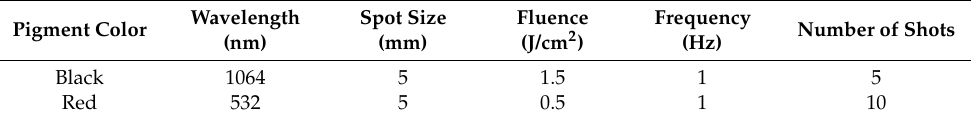
Table 1. Laser parameters used for tattoo